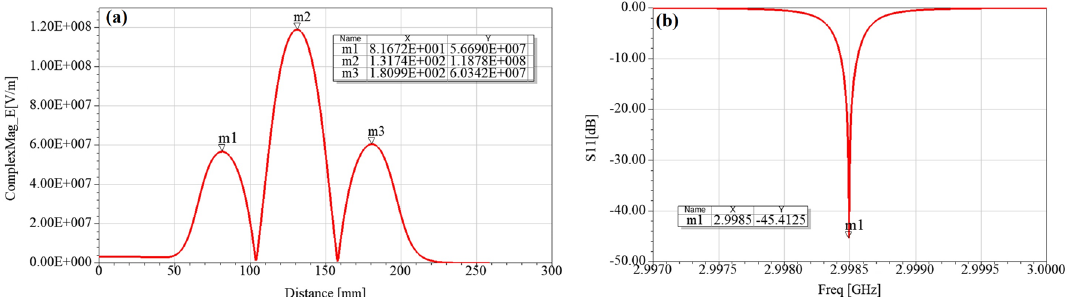
Figure 8. Axial electric field ( a ), and reflection coefficient ( b ) for 8 MW input power.